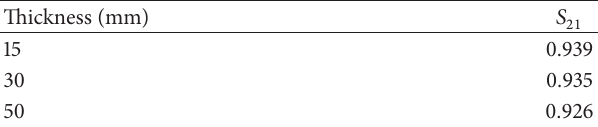
Table 1: Corresponding 𝑆 parameter values with material